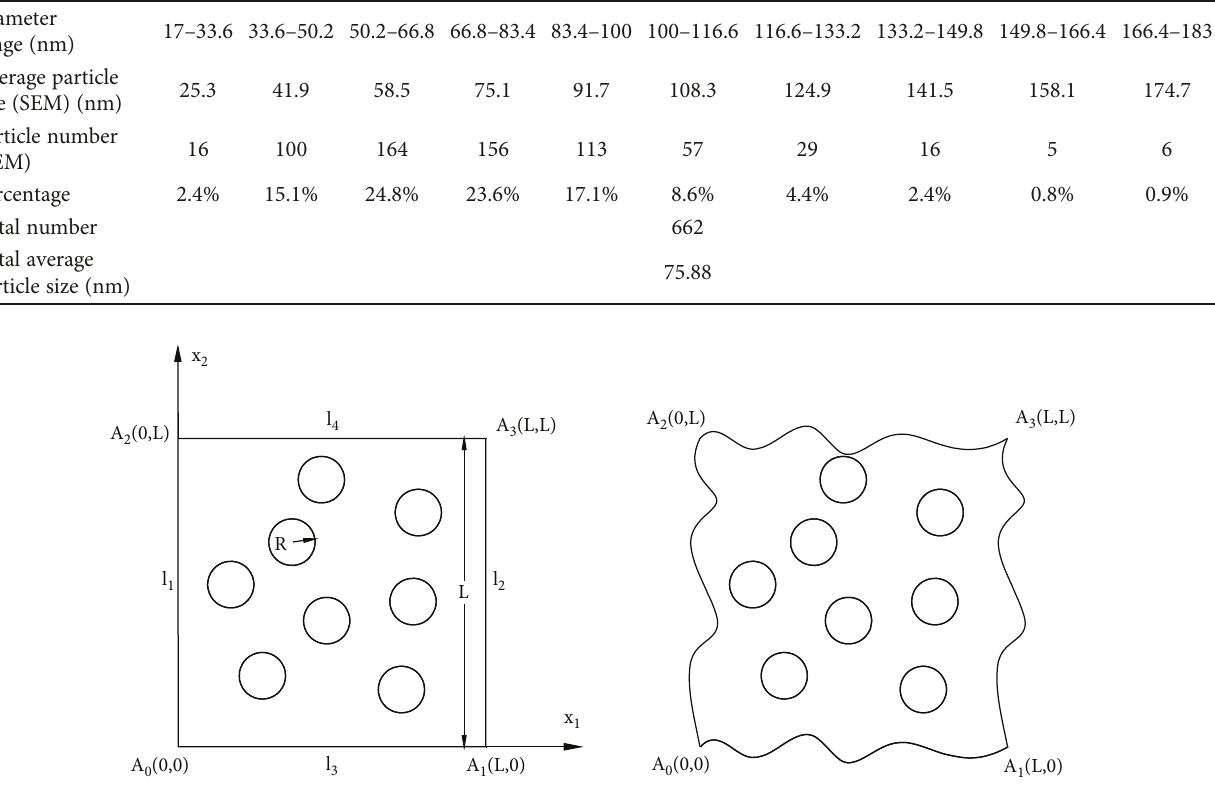
Figure 4: Schematic of the 2D RVE model.